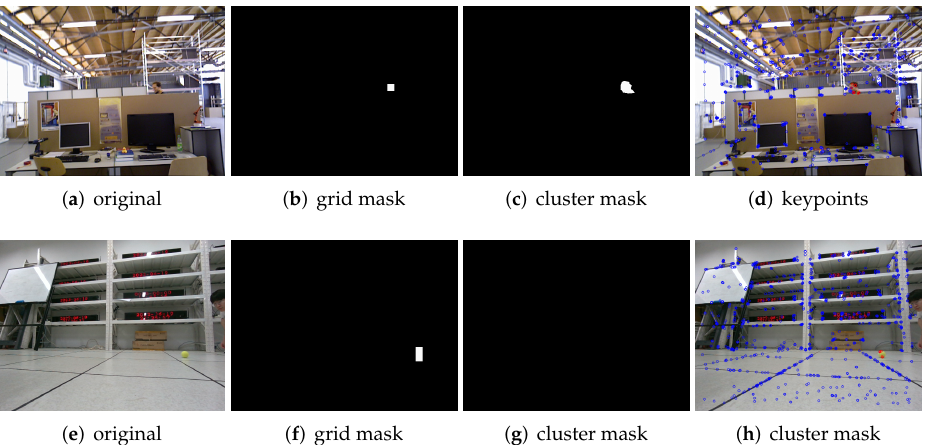
Figure 7. ( a – d ) show the cases of small object motion on the public data sets, as does Figure 5. ( e , f ) show the cases of small object motion taken with camera. In ( a ), only a head of the human body appears in the image. ( b ) shows the results using Algorithm 1. ( c ) shows the results using Algorithm 1. ( d ) shows the dynamical key points and the static key points using the algorithm DGFlow-SLAM. ( e ) shows an image of a small ball rolling, and ( f ) is the result of Algorithm 1. ( g ) is the result of Algorithm 2. ( h ) shows the dynamical key points and static key points using the algorithm